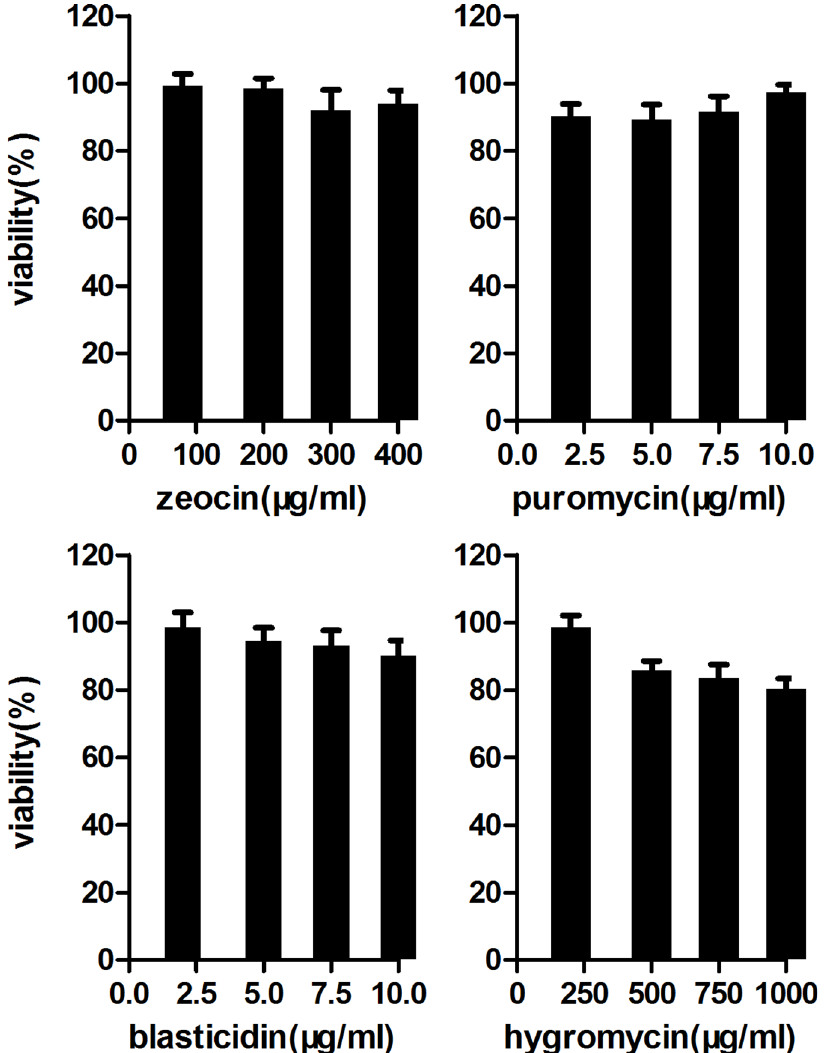
Fig. 2. Antibiotic resistance of mitomycin treated SNL DG5 feeder layer. About 2 6 10 4 mitomycin C- treated SNL DG5 feeder cells were plated in each well of 96-well plate. The medium was added with different antibiotics concentrations and each concentration was in quadruplicate. Medium was changed every two days and the cells were cultured for 7 days. Survival rate is calculated by comparing to parallel-plated cells without antibiotics selection and expressed as a